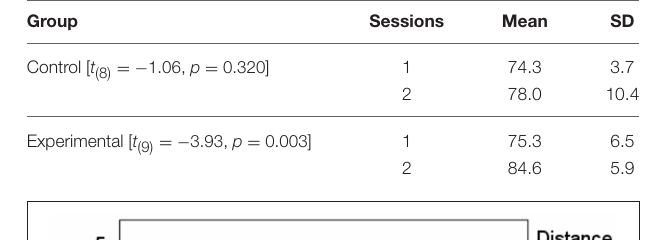
TABLE 1 | Mean accuracy values (%) for each group compared post-hoc between sessions.